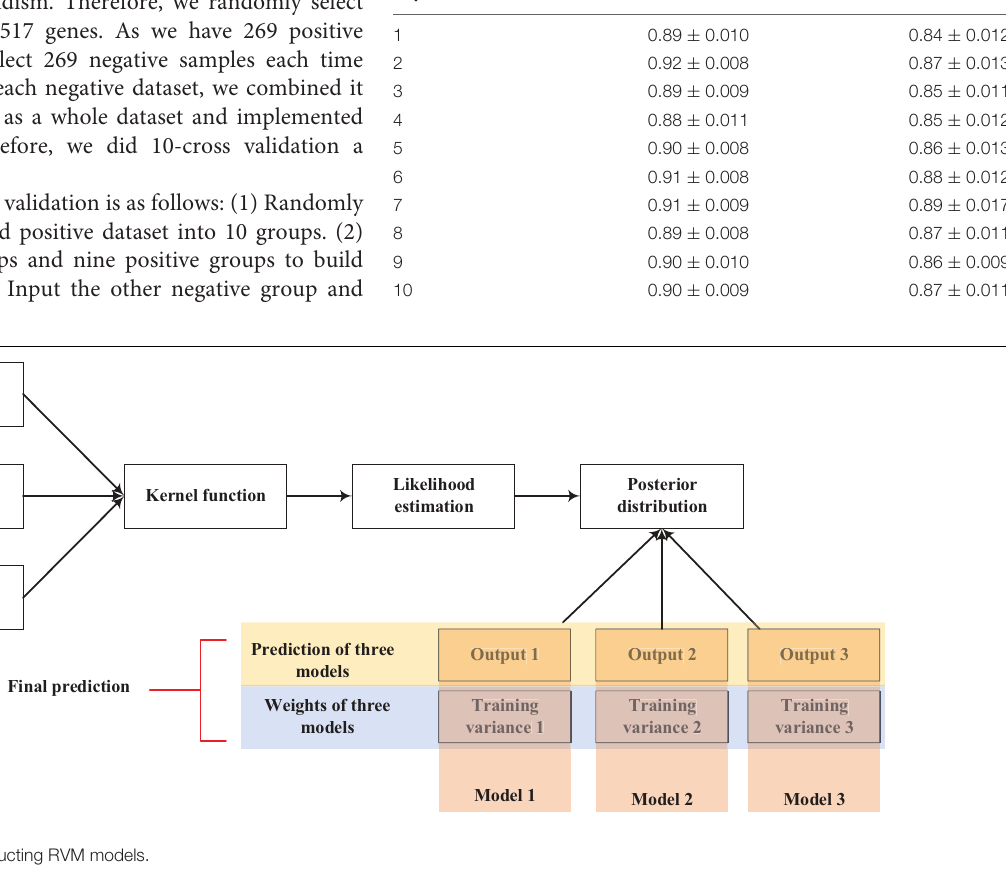
TABLE 3 | The AUC and AUPR of 10-cross validation. Experiment